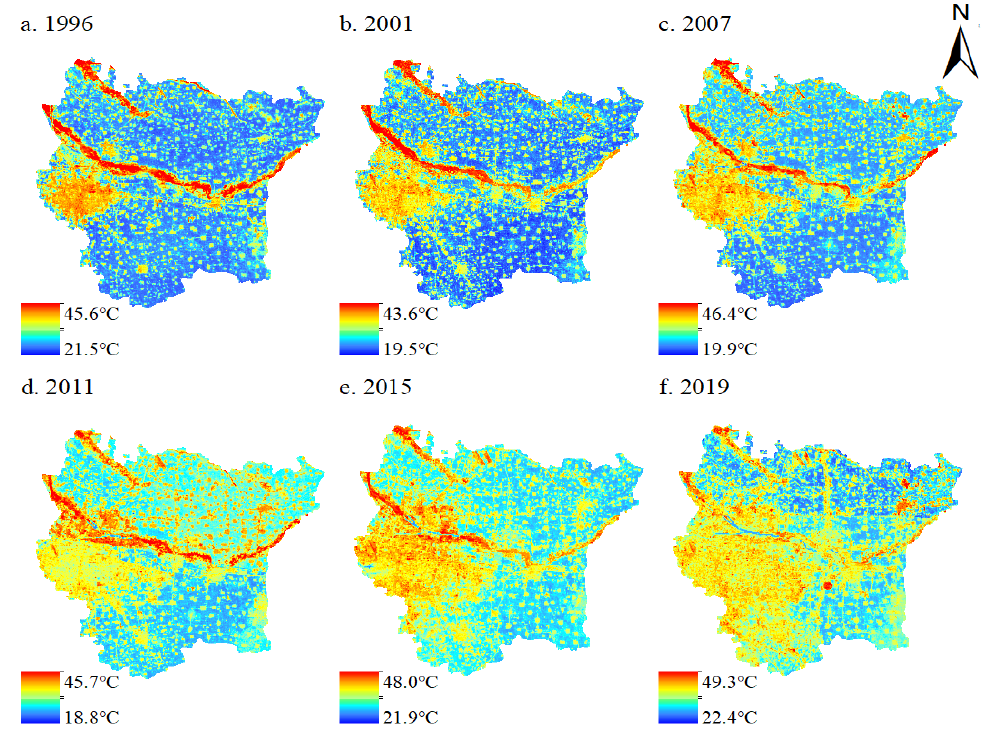
Figure 4. Spatial pattern of the land surface temperature (LST) in the study area from 1996 to 2019.